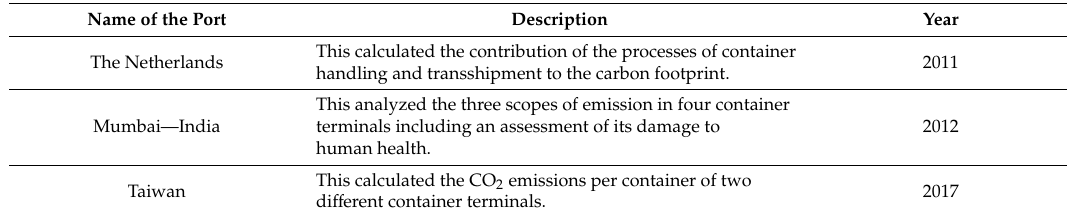
Table 4. Existing methodologies in port